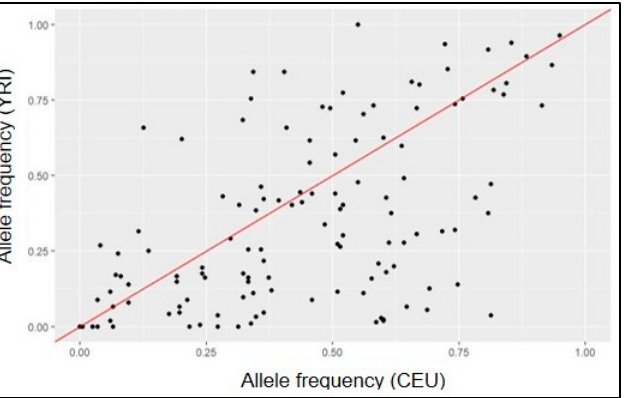
Figure 1. Comparison of allele frequencies of 127 known POAG SNPs in ancestral populations (1000G YRI vs. CEU).